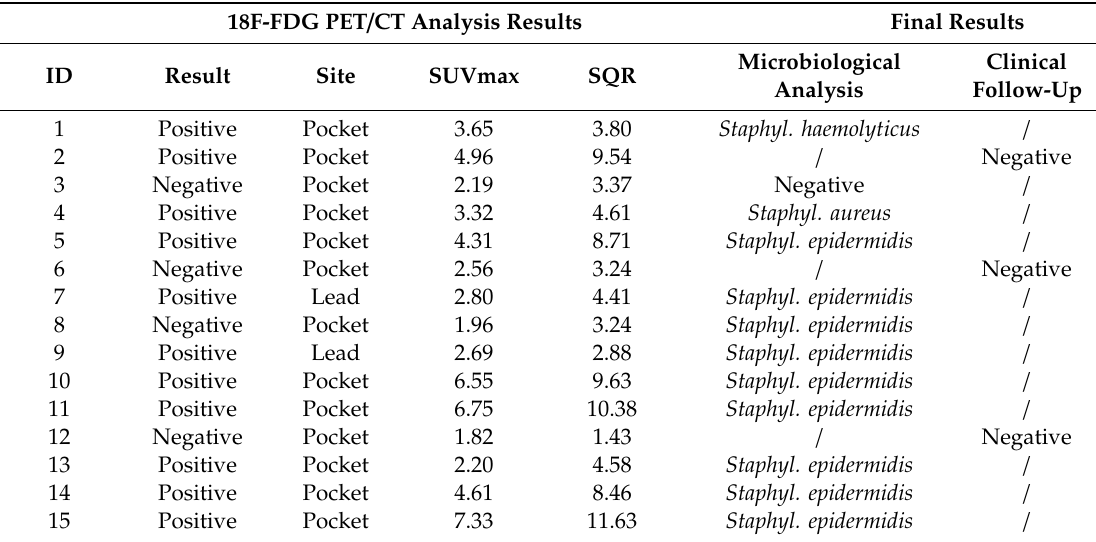
Table 2. 18 F-FDG PET / CT and final results in CIEDIsusp